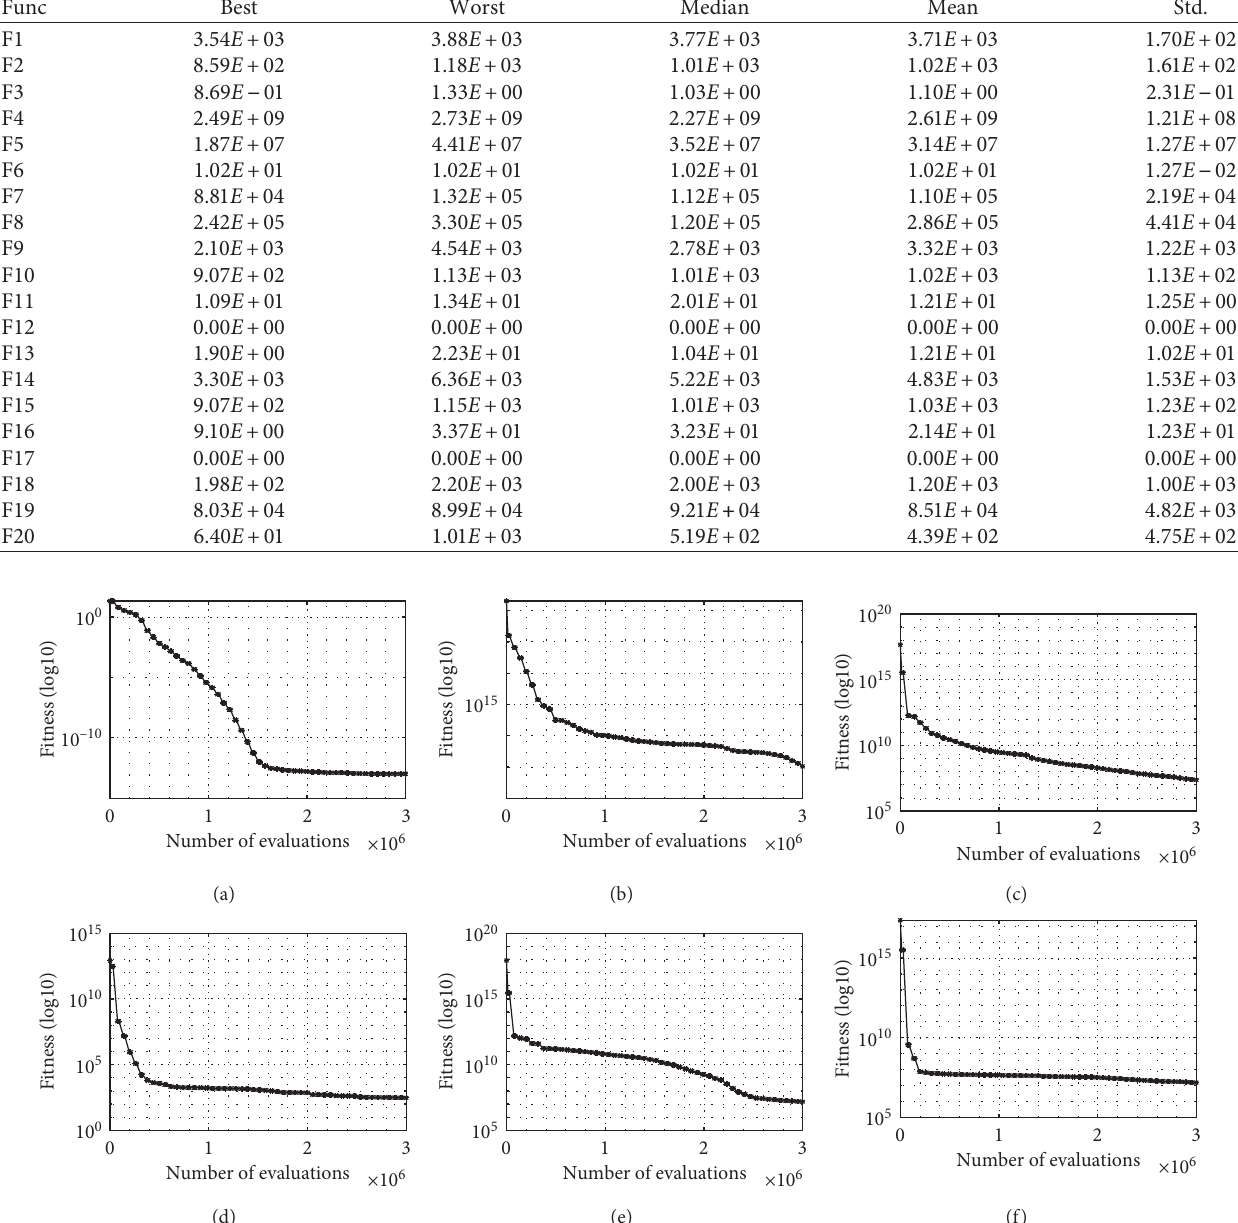
Table 2: GI-ES statistical results using CEC2010, the statistical results for all functions include best, worst, median, mean, and standard deviation calculated over 25 runs. Func